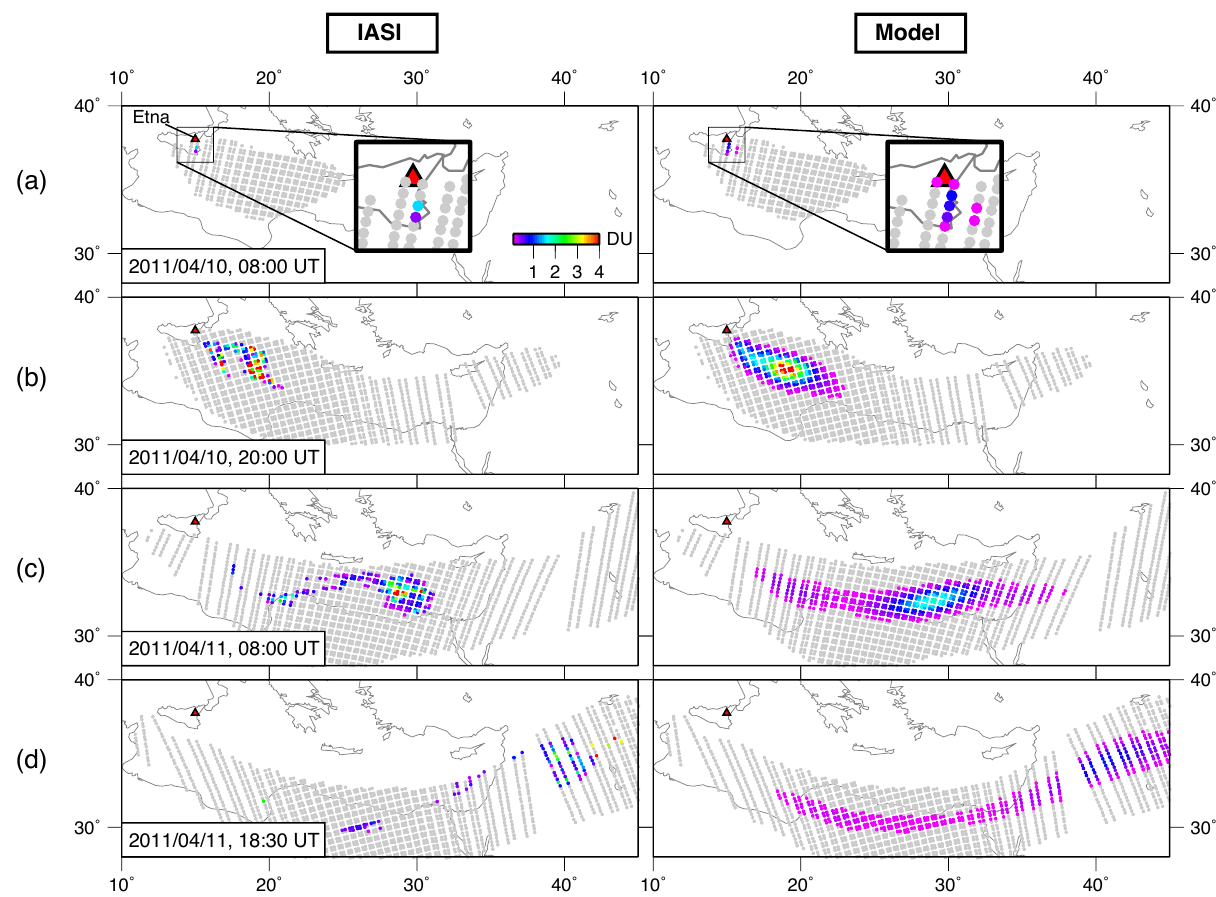
Figure 2. Maps of SO 2 column amounts (DU) in the Etna volcanic cloud on 10 and 11 April 2011 (left) retrieved from IASI observations acquired over a time window centered at the date indicated, and (right) simulated with the CHIMERE chemistry-transport model initialized with emissions reconstructed by the inversion procedure. Regions in grey indicate column amounts < 0 .